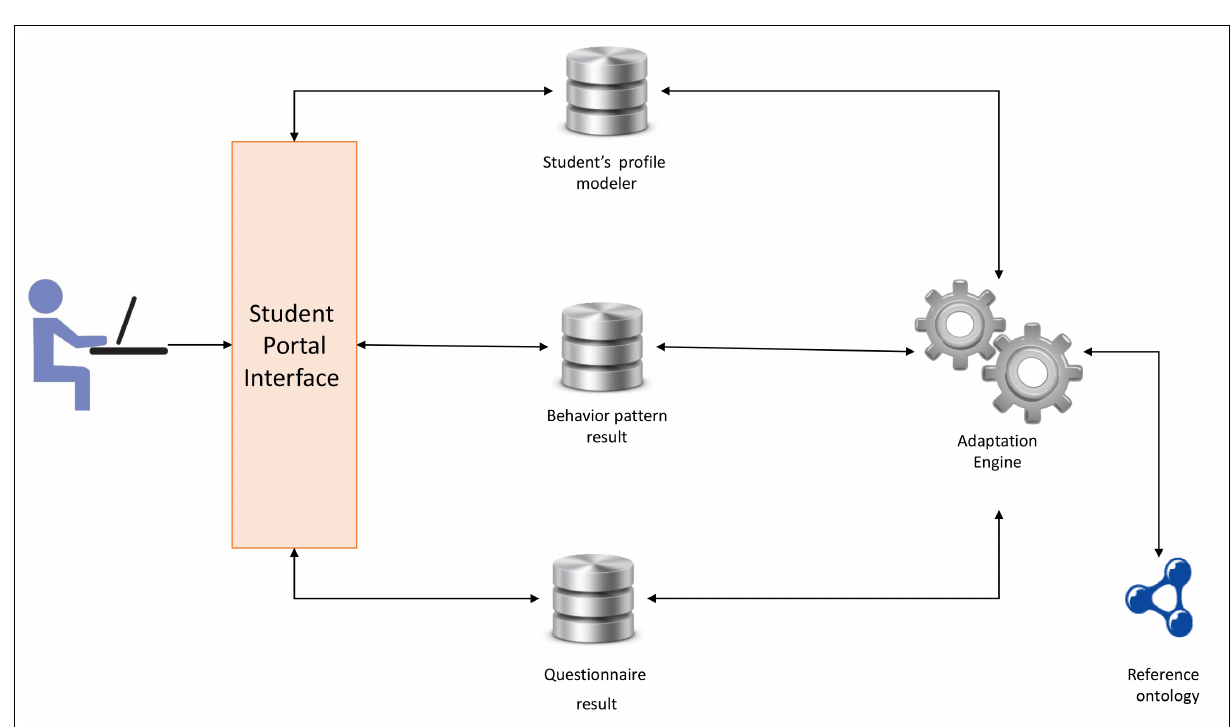
Figure 5. Proposed student profile